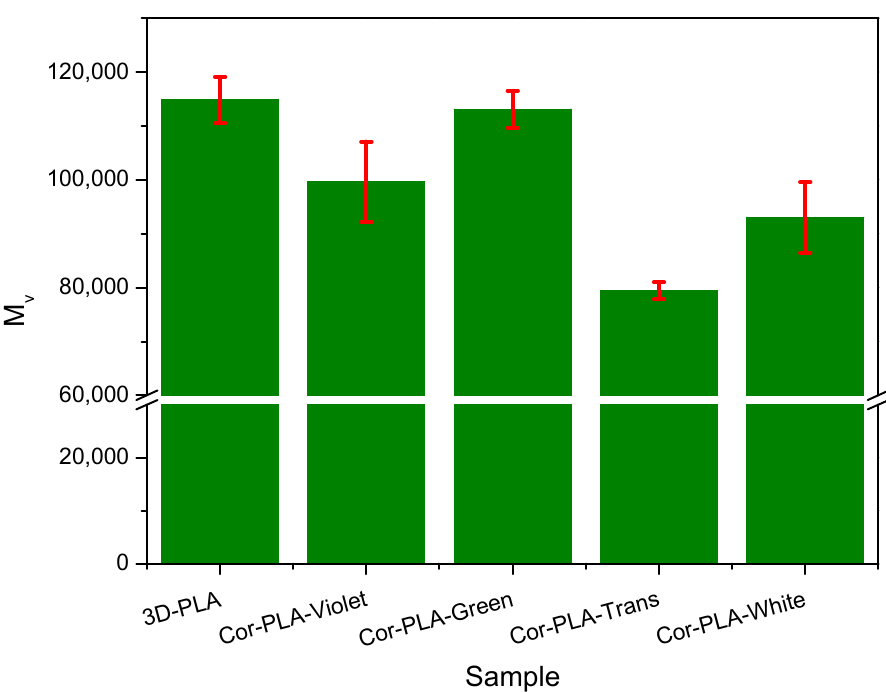
Figure 5. Viscosimetric average molecular weight of the components of the 3D printing wastes.